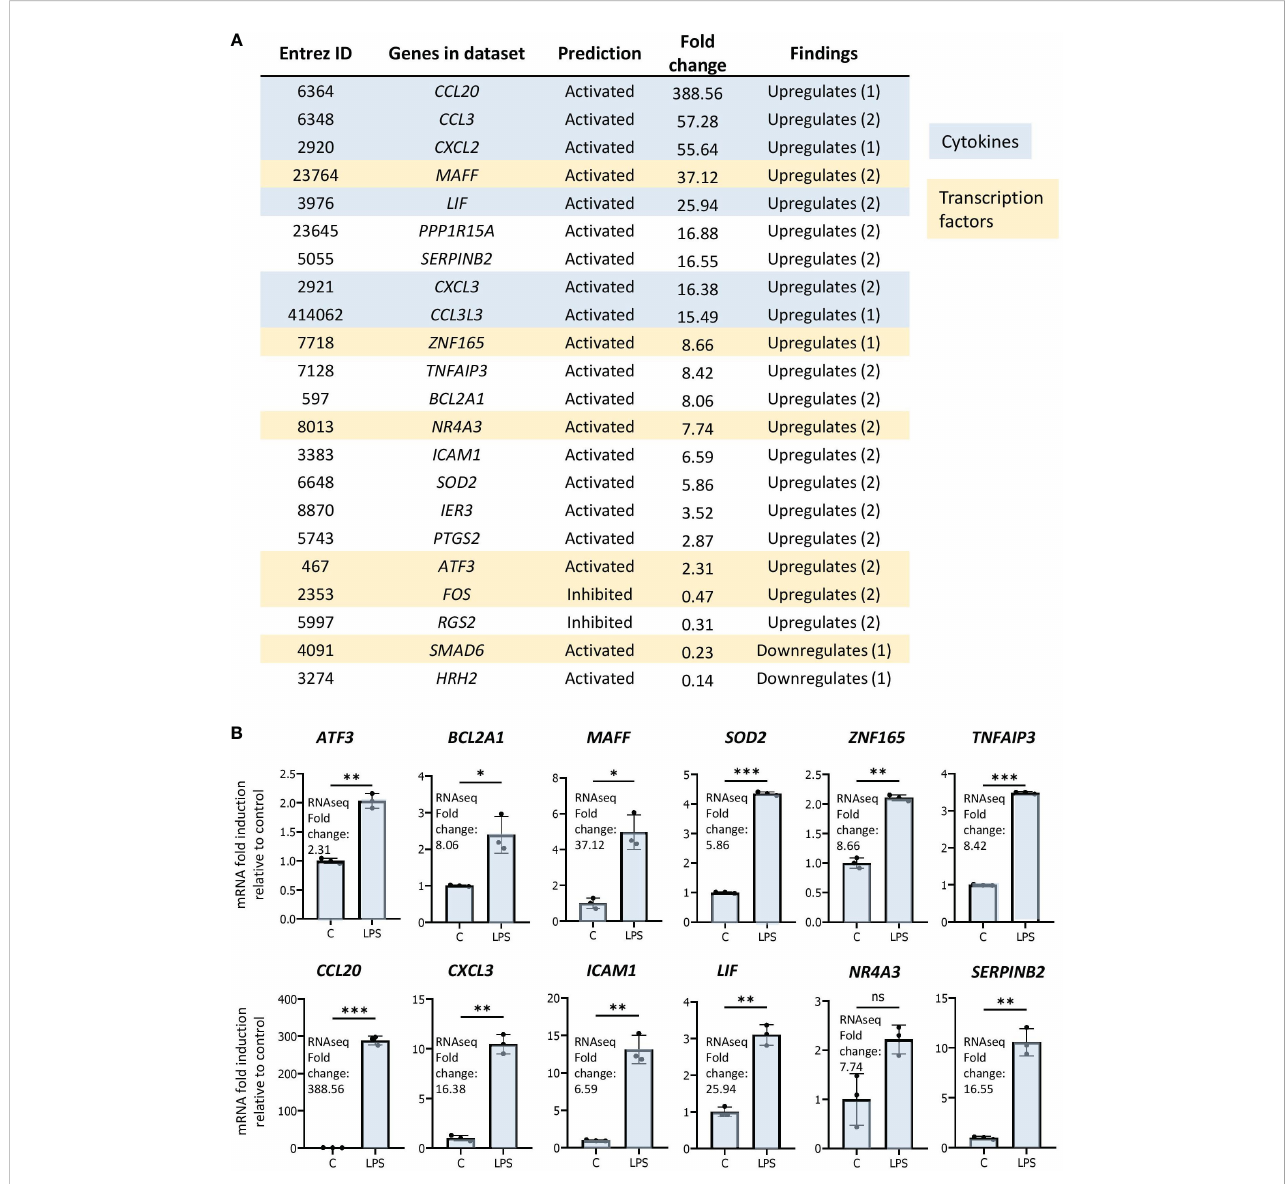
FIGURE 4 The FOXL2 network is enriched in genes encoding in fl ammation-associated transcription factors, cytokines and regulators of neutrophil function. (A) All genes included in the network with corresponding Entrez ID, activated or inhibited prediction, fold change gene expression relative to control and whether the gene is up or downregulated based on previous fi ndings in the literature. Genes that are cytokines are highlighted in blue, and genes that represent transcription factors are in beige. (B) RT/qPCR analysis of LPS-regulated expression of genes within the FOXL2 network in human neutrophils. Graphics representative of 2 or 3 biological replicates. Graphics are mean ± SD from 3 technical replicates from a representative sample and paired, two- tailed t-test (Student ’ s t-test) was used (*P ≤ 0.05, **P ≤ 0.01, ***P ≤ 0.001 and ns ≥